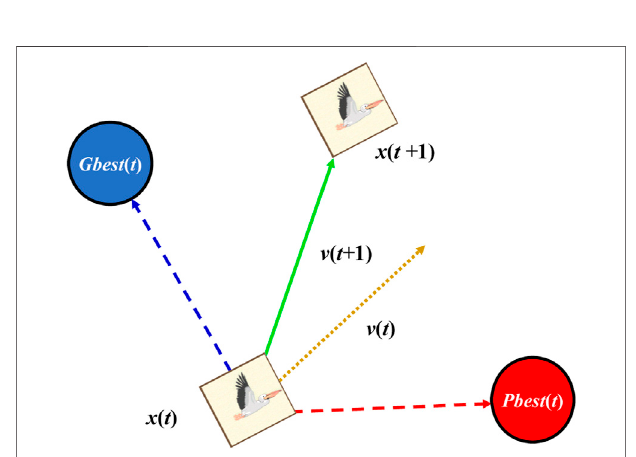
FIGURE 6 | Search trajectory of particle swarm